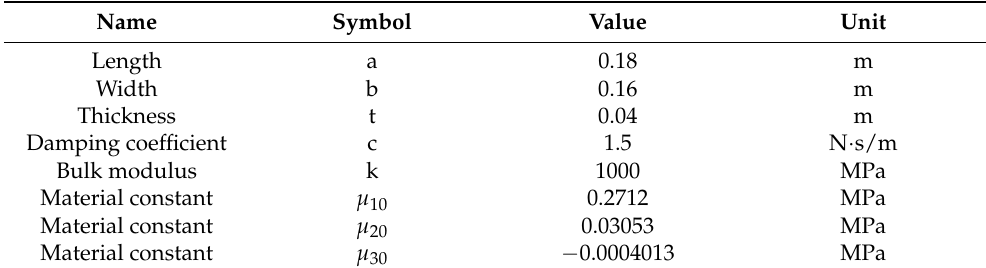
Table 1. Geometrical and material parameters of a silicone rubber plate in this example.